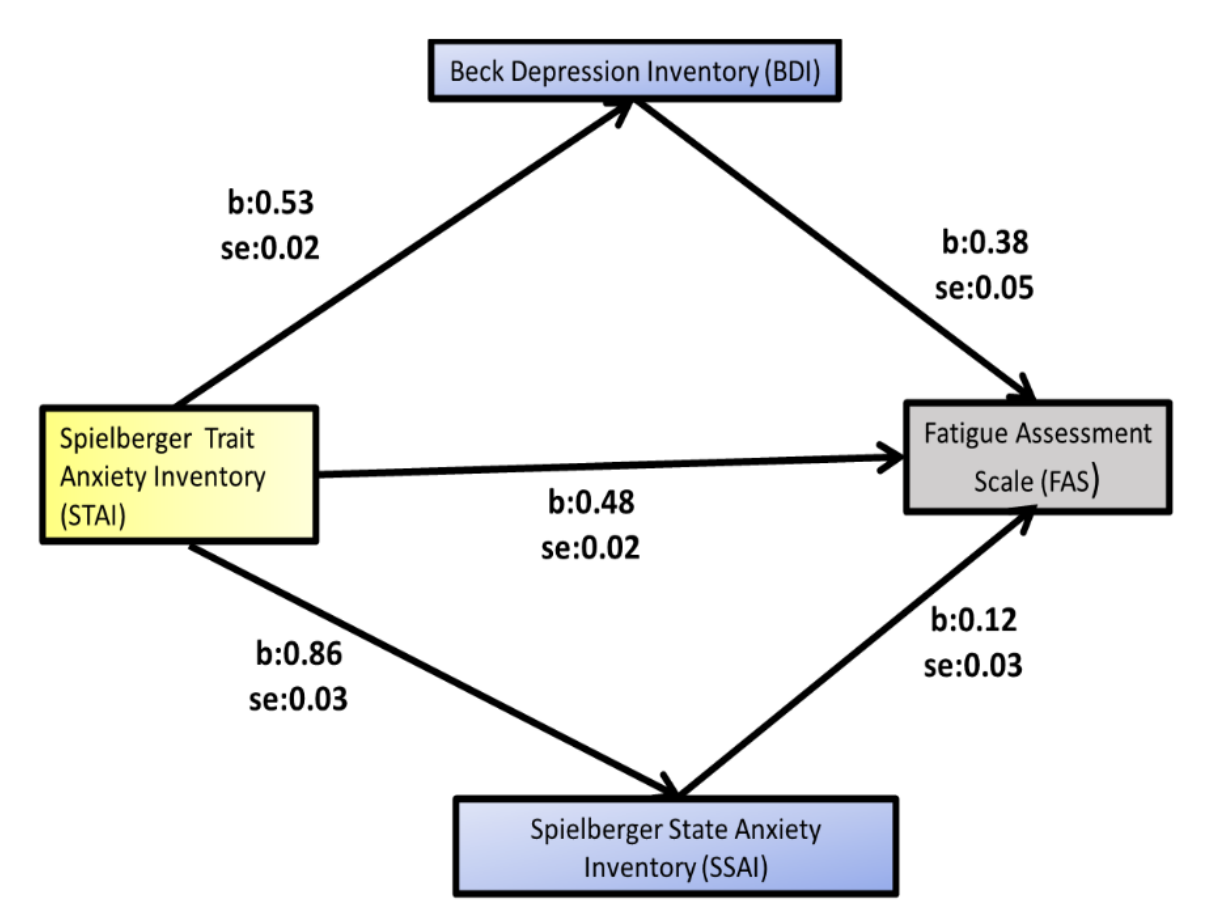
Table 4. Mediation analysis of Beck Depression Inventory (BDI) and Spielberger State Anxiety In- ventory (SSAI) on Spielberger Trait Anxiety Inventory (STAI) – Fatigue Assessment Scale (FAS) re- lationship *.